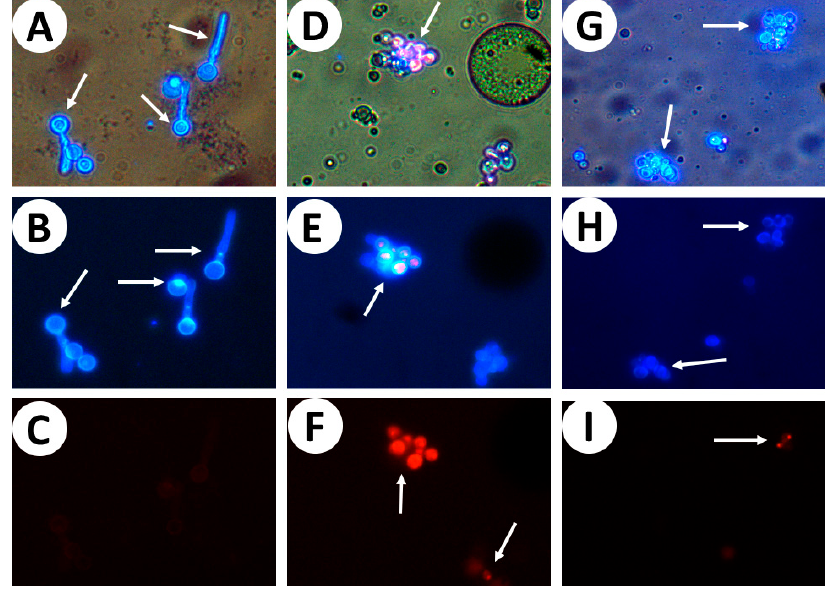
Figure 4. Microphotographs (40×) obtained in fluorescence microscopy and dyed with Calcofluor-white stain (( B , E , H ), λ = 360 nm) and propidium iodide (( C , F , I ), λ = 536 nm). Visible light ( A , D , G ). ( A – C ) shows the control, while ( D – F ) are the yeasts exposed to essential oil (10 mg/mL) for 2 h. ( G – I ) show the yeasts exposed to essential oil (2 mg/mL) for 2 h.